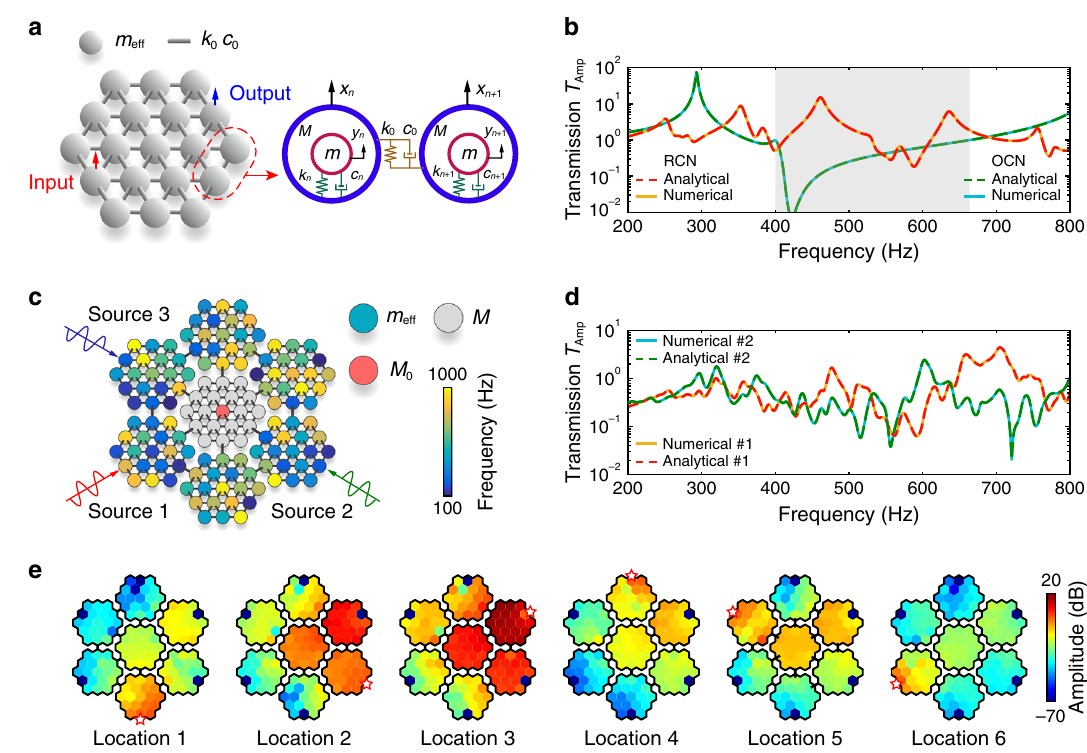
Fig. 1 Randomly coupled resonator system for spatial vibration encoding. a Schematic of a simpli fi ed coupling network. b Transmissions of the ordinary coupling network (OCN) and the randomized coupling network (RCN) calculated by analytical and numerical methods. c The entire coupling system composed of six different RCNs for vibration identi fi cation. The colors of the resonators denote the resonant frequencies. d Transmissions of the coupling system excited at two terminals respectively. e Vibration modes of the coupling system excited at different terminals at 600